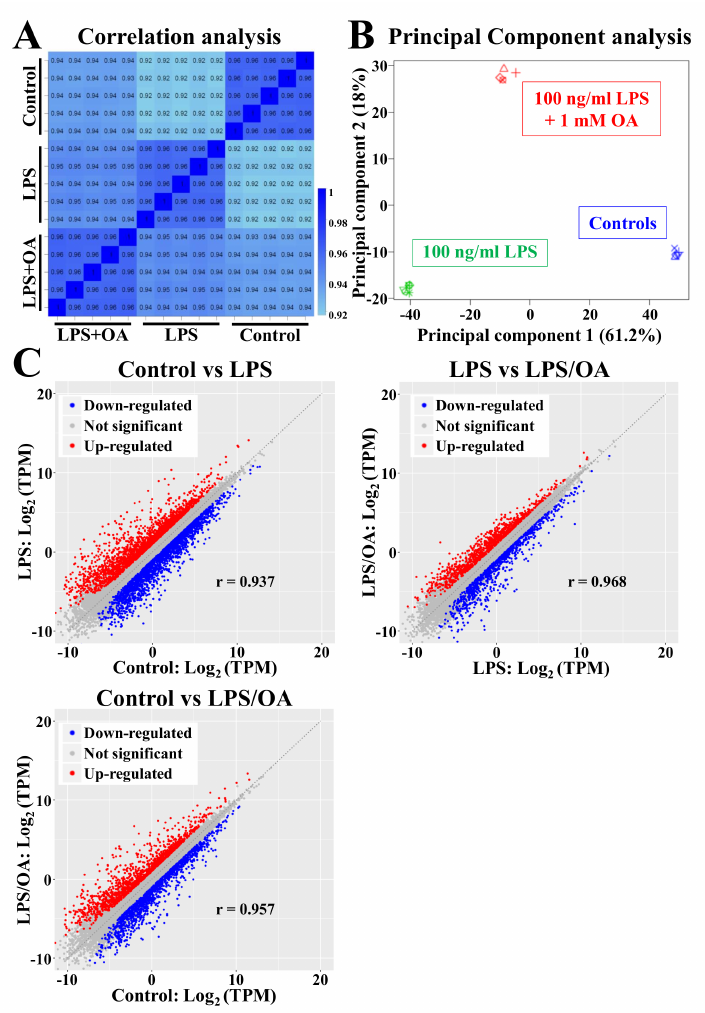
Figure 4. RNA-seq analysis reveals different gene expression profiles in the control, LPS, and LPS/OA groups. (A) Correlation analysis of RNA-seq results. The color of the block indicated the correlation co-efficient. (B) Principle component analysis of the RNA- seq results. (C) Volcano plot of the RNA-seq results. Blue dots indicated expression of down-regulated genes while red dots indicated expression of up-regulated genes. The correlation co-efficient (r) between compared groups was indicated in each